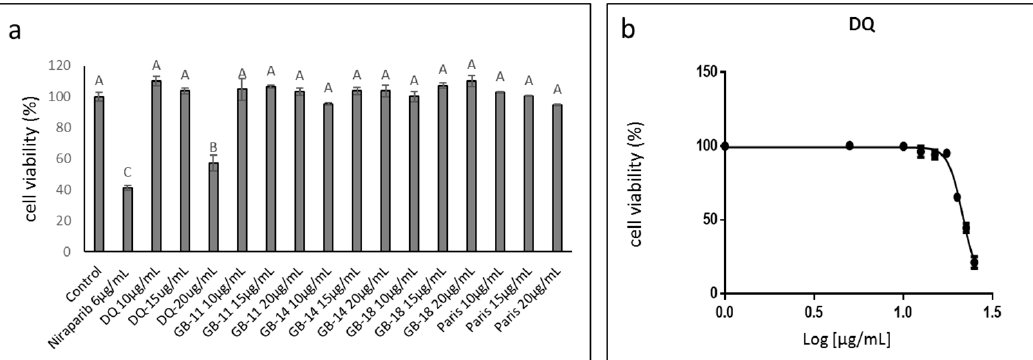
Figure 1. ( a ) Cell viability of HTB75 cells following treatment with the crude extract of cannabis strains DQ, GB-11, GB-14, GB-18 and Paris. Cell viability was determined by XTT assay as a function of live cell number at 48 h. Control was the vehicle-treated control (1.00% v/v methanol). Error bars indicate ± SE ( n = 3). Levels with different Upper case letters were significantly different from all combinations of pairs according to the Tukey – Kramer honest significant difference (HSD; p ≤ 0.05). ( b ) Cell viability following treatment with C. sativa DQ crude extract at different concentrations for IC50 value calculation from 5P logistic curve fit using GraphPad Prism version 6.1. Concentration 0 was the vehicle-treated control (1.25% v / v methanol). Error bars indicate ± SE ( n = 3).